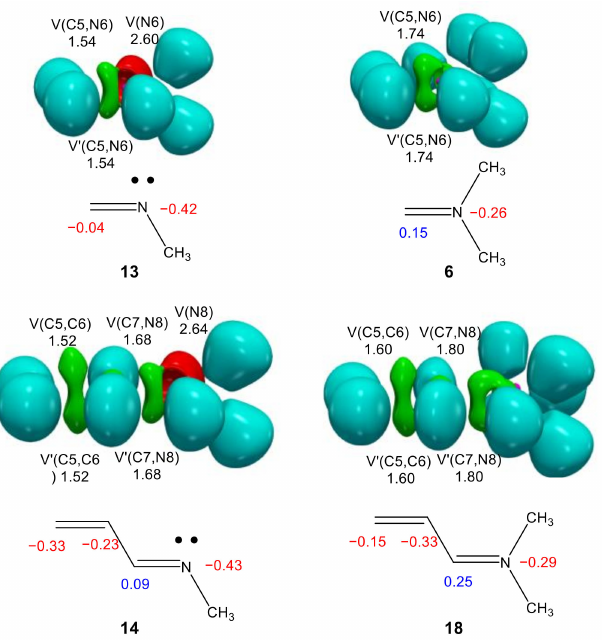
Figure 3. ω B97XD/6-311G(d,p) localization domains (isosurface value = 0.75): blue color is used to show protonated basins, red color for the monosynaptic basins, green color for the disynaptic basins and magenta color for core basins, ELF based Lewis-like structures, and natural atomic charges, in average number of electrons e, blue color is used for positive charges and red color for negative charges, of imines 13 and 14 , and iminium cations 6 and 18